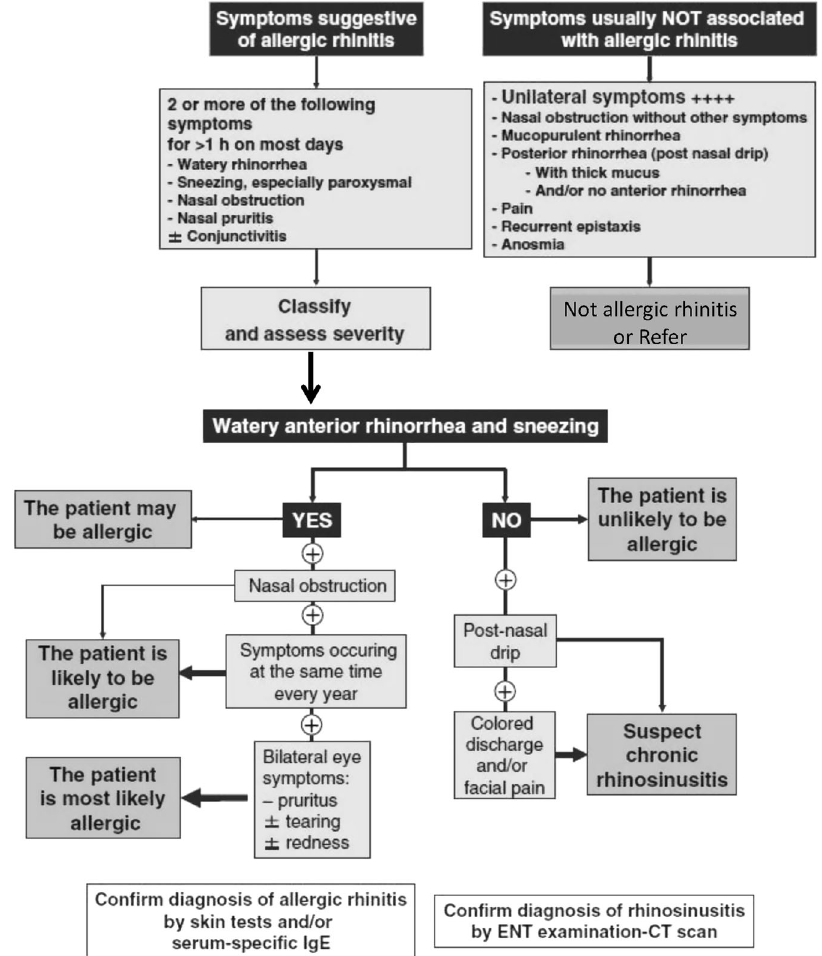
Fig. 1 Diagnosis of allergic rhinitis through symptom assessment. Adapted from ARIA Bousquet 2008. 23 IgE: immunoglobulin E; ENT: Ear Nose Throat; CT: computed